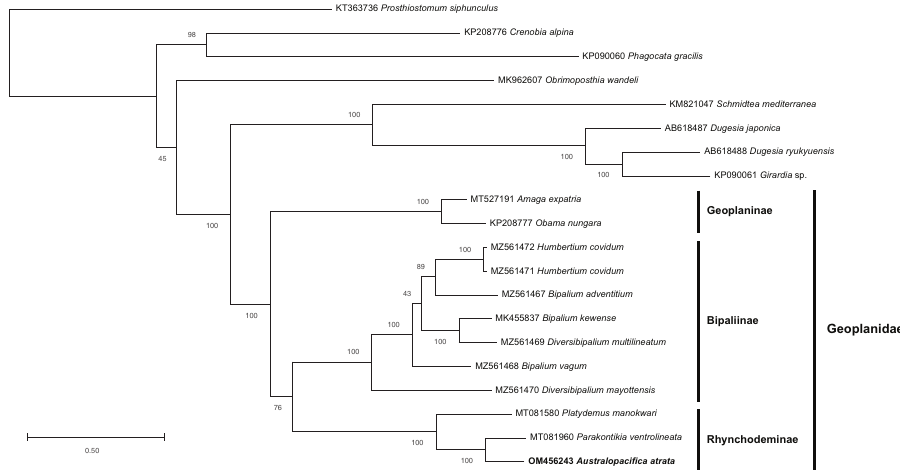
Figure 4. Maximum Likelihood phylogenetic tree obtained from concatenated amino-acid sequences of the mitochondrial proteins of Australopacifica atrata (Steel, 1897) and other flatworms. The tree with the best likelihood is shown (-75607.404300). Subfamilies of Geoplanidae are indicated on the